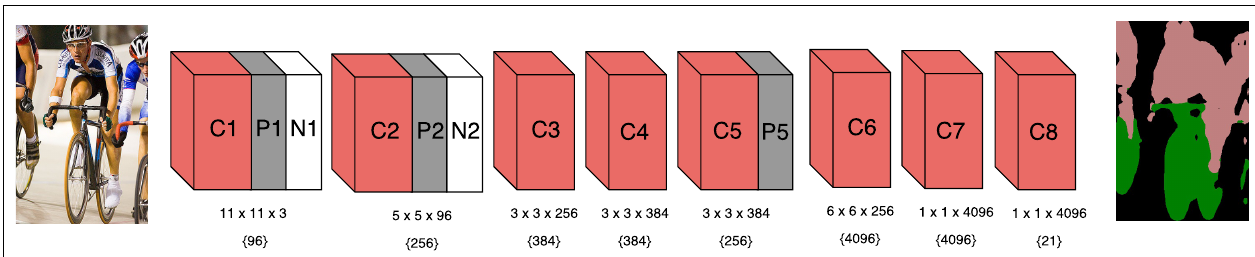
FIGURE 3 | Fully Convolutional Net: AlexNet modified to be fully convolutional for performing semantic object segmentation on PASCAL VOC 2012 dataset with 21 classes .